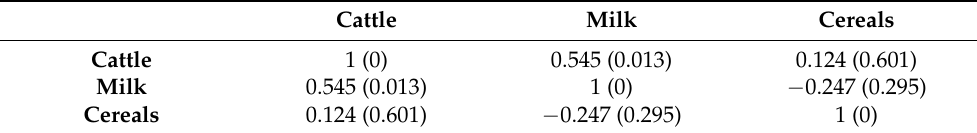
Table A10. Correlation coefficients ( p -value) for mixed farms product group environmental